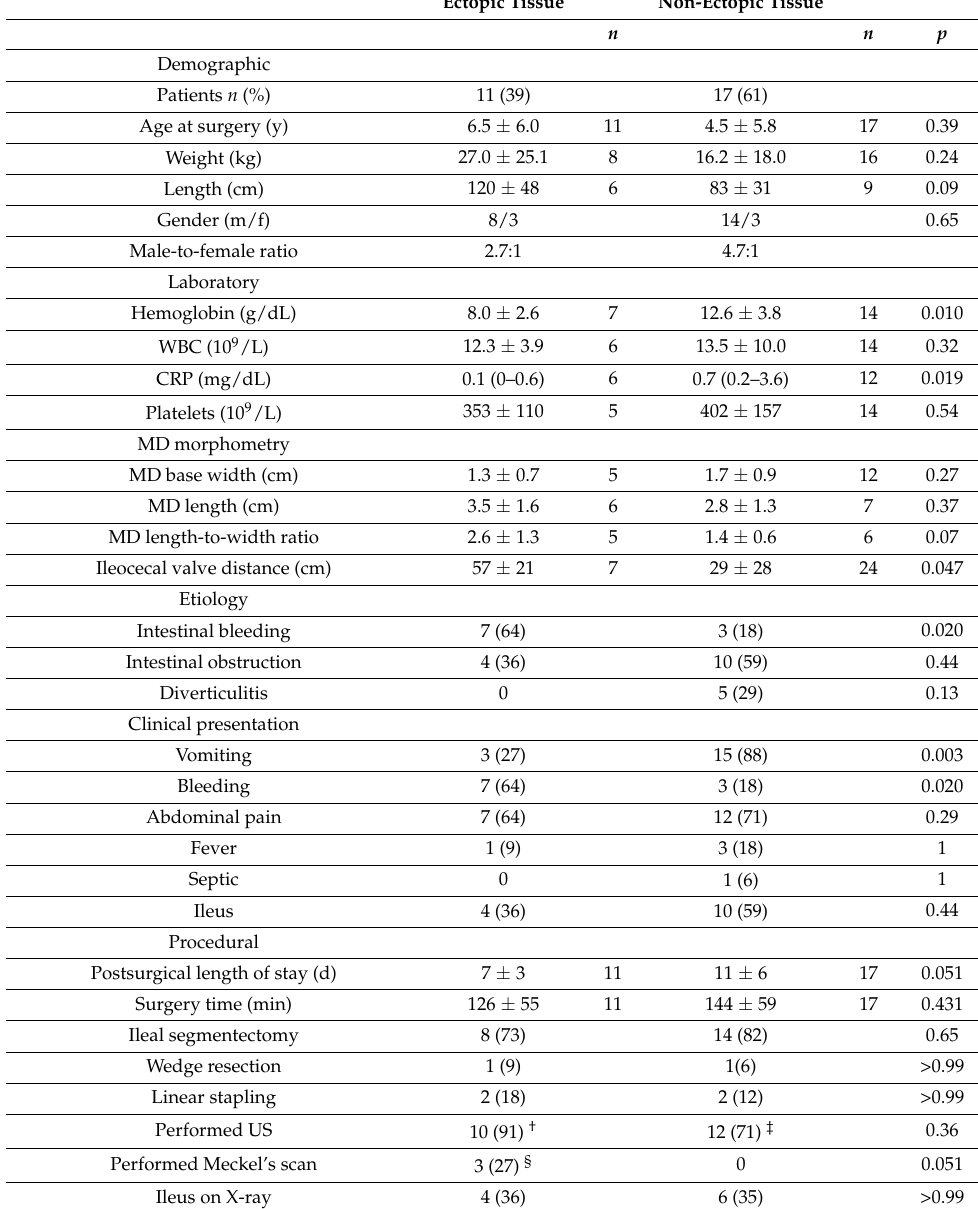
Table 3. Ectopic versus non-ectopic tissue finding in symptomatic Meckel’s diverticula. Ectopic